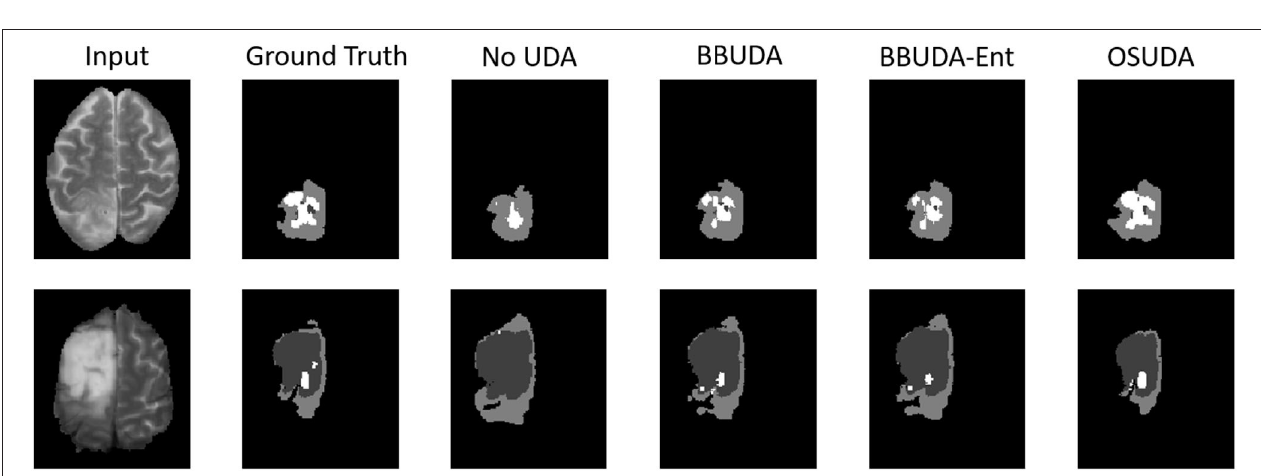
FIGURE 2 | Examples of MRI slices of LGG and HGG samples. Each sample has four MR modalities, i.e., T1-weighted MRI, T1ce MRI, FLAIR MRI, and T2-weighted MRI.